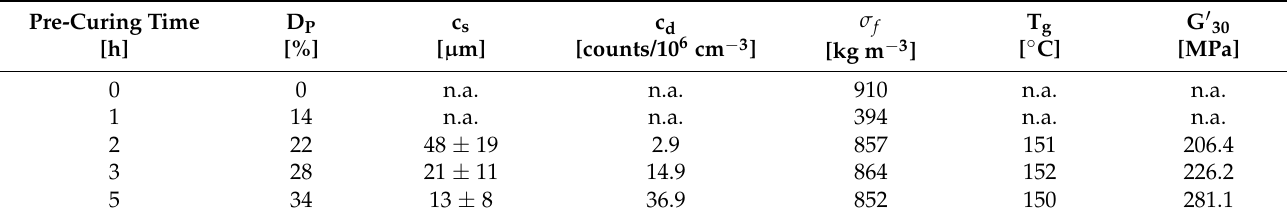
Table 3. DbI 30/70w foam properties with regard to pre-curing degree (D P ), cell size (c s ), cell distribution (c d ), foam density ( σ f ) (process-adjusted density is 860 kg m − 3 ) and T g (loss modulus G” max. in DMA) as well as the storage modulus (G (cid:48) ) received at 30 ◦ C from DMA (G (cid:48) 30 ) of the different blend